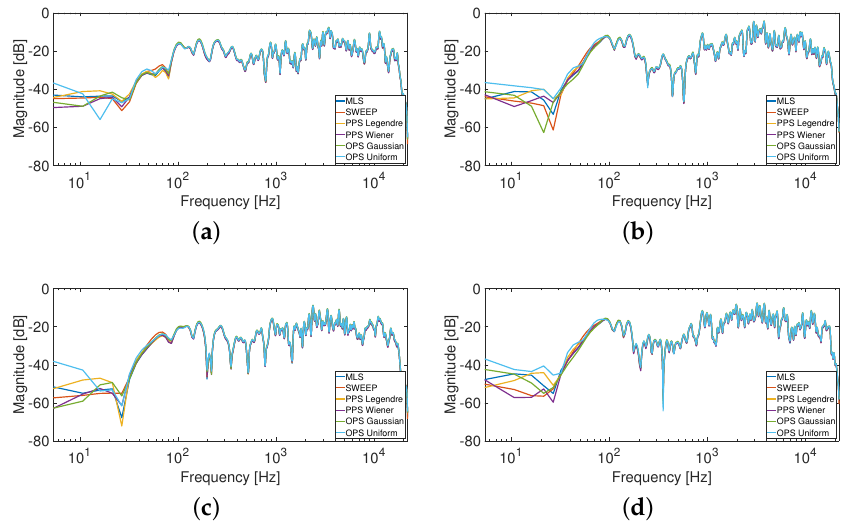
Figure 3. HRTFs measurement at driver position, where ( a ) is the response of the left ear from the left speakers, ( b ) is the response of the left ear from the right speakers, ( c ) is the response of the right ear from the left speakers, and ( d ) is the response of the right ear from the right speakers. A smoothing of 1/12 octave band was applied to the responses.